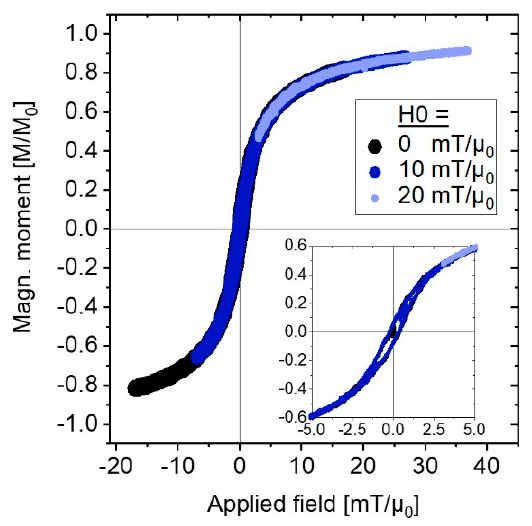
Figure 2. Exemplary magnetization curves ( M ( H )-loops) generated from micromagnetic MC-simulations for different static offset fields H 0 = ( 0,10,20 ) mT/ µ 0 . Inset shows magnification of small applied fields, revealing a slight opening of the loops.